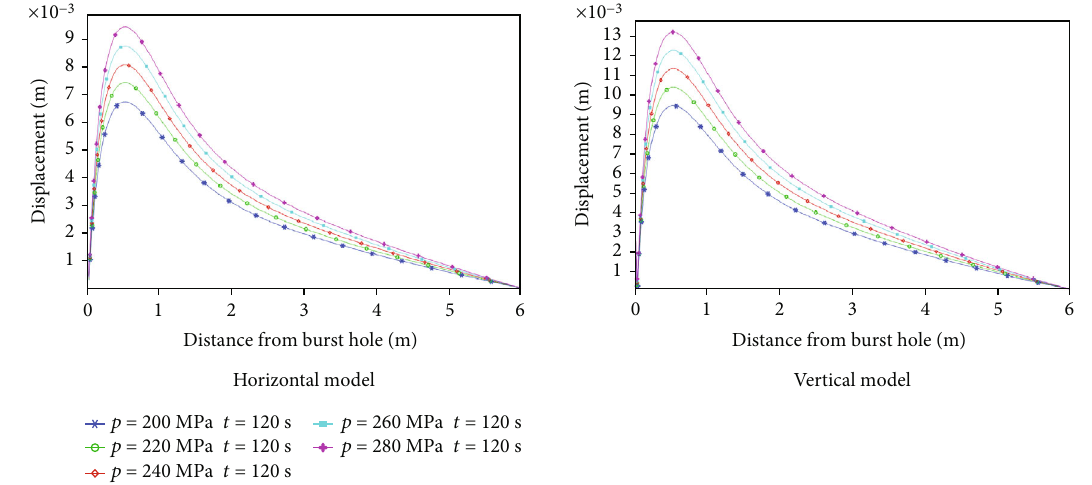
Figure 6: Curve of displacement with distance from the blasting port under di ff erent blasting